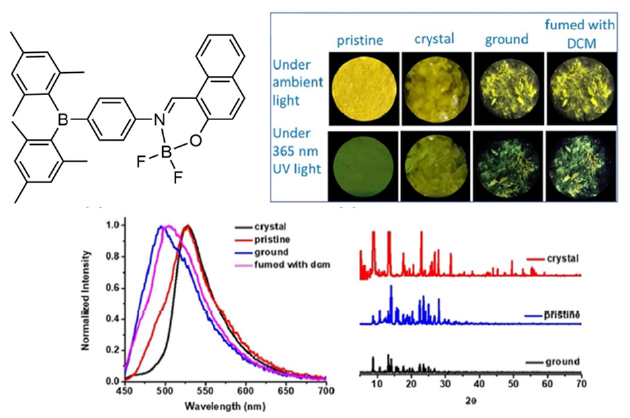
Figure 6. Examples of boranils complexes exhibiting mechanofluorochromic fluorescence emission [53]. Adapted from Reference [53]. Copyright 2020 John Wiley and Sons.